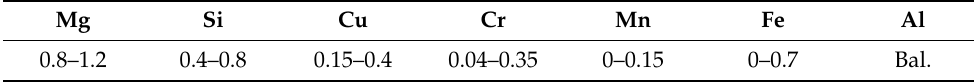
Table 1. The nominal composition of Al 6061 alloy (wt.%)